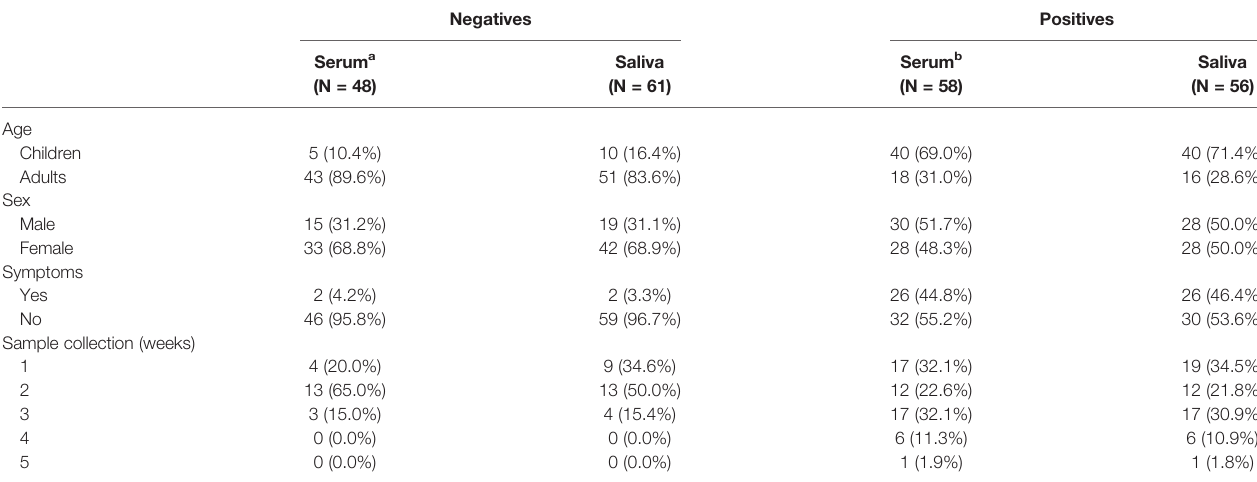
TABLE 1 | Characteristics of study participants from whom samples were